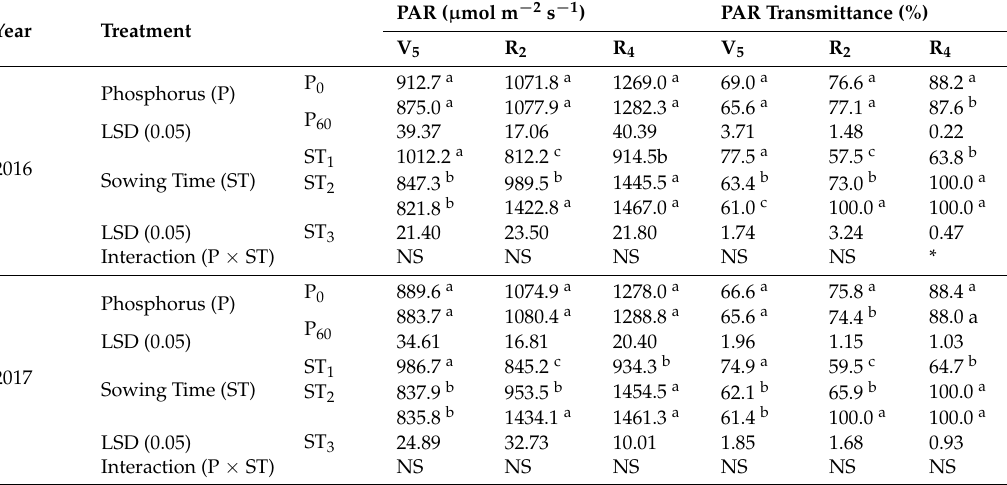
Table 2. Photosynthetically active radiation (PAR) and PAR transmittance of soybean canopy at three stages of phenological development as affected by two rates of phosphorus fertilizers during the cropping seasons of 2016 and 2017 under maize soybean relay intercropping